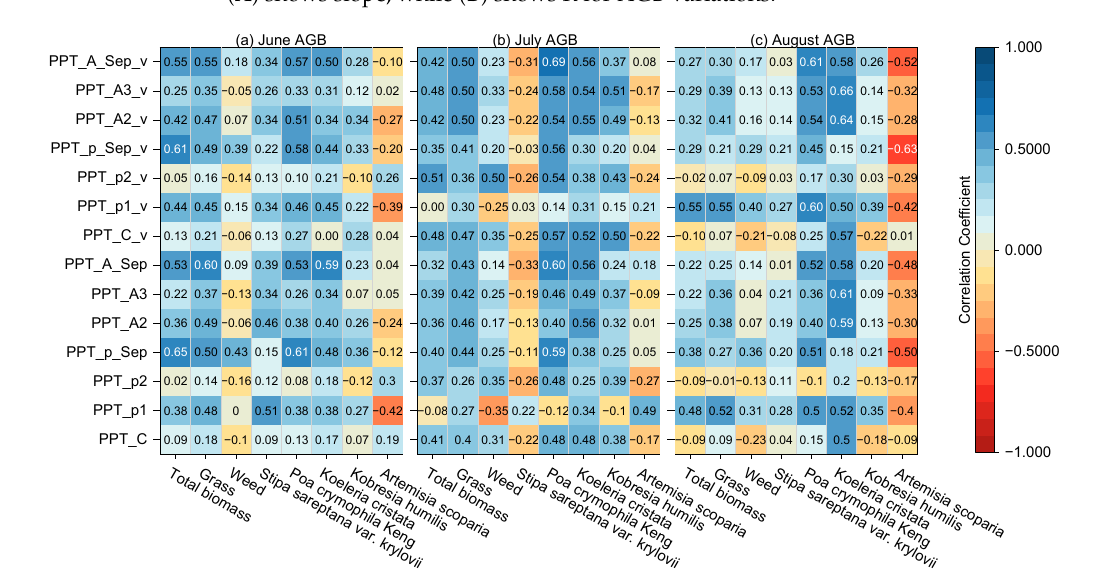
Figure 4. Correlations between multi-species AGB (( a ): June AGB; ( b ): July AGB; ( c ): August AGB) and multi-period precipitation in Qinghai Lake region during 1997–2011. Multi-period